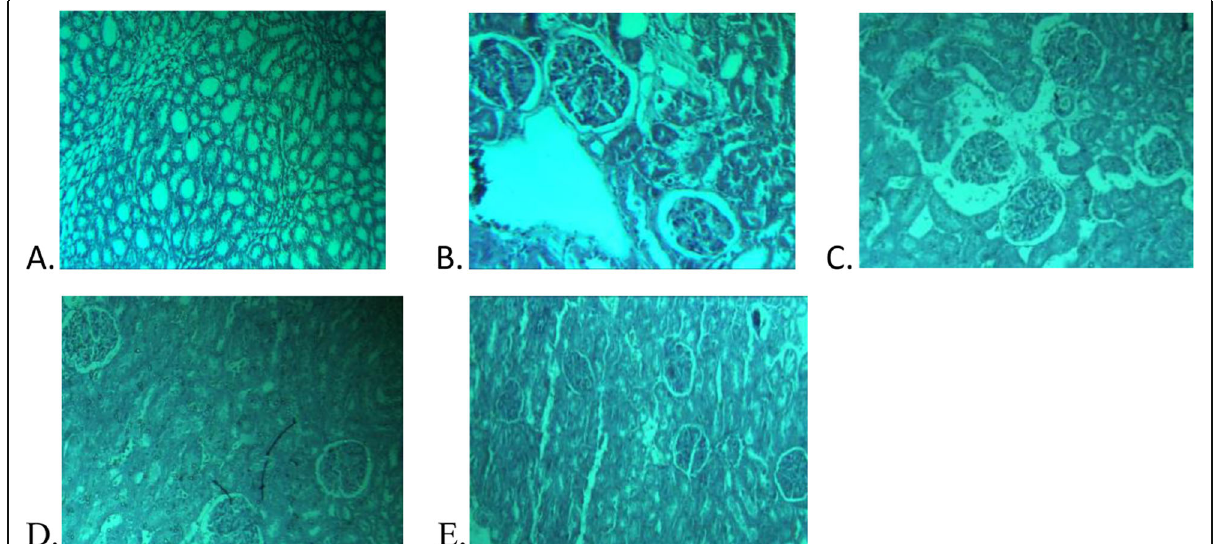
Fig. 9 a Normal control. b Disease control. c Oleamide (5mg/kg). d AM6545 (16mg/kg). e Oleamide (5mg/kg)+AM6545